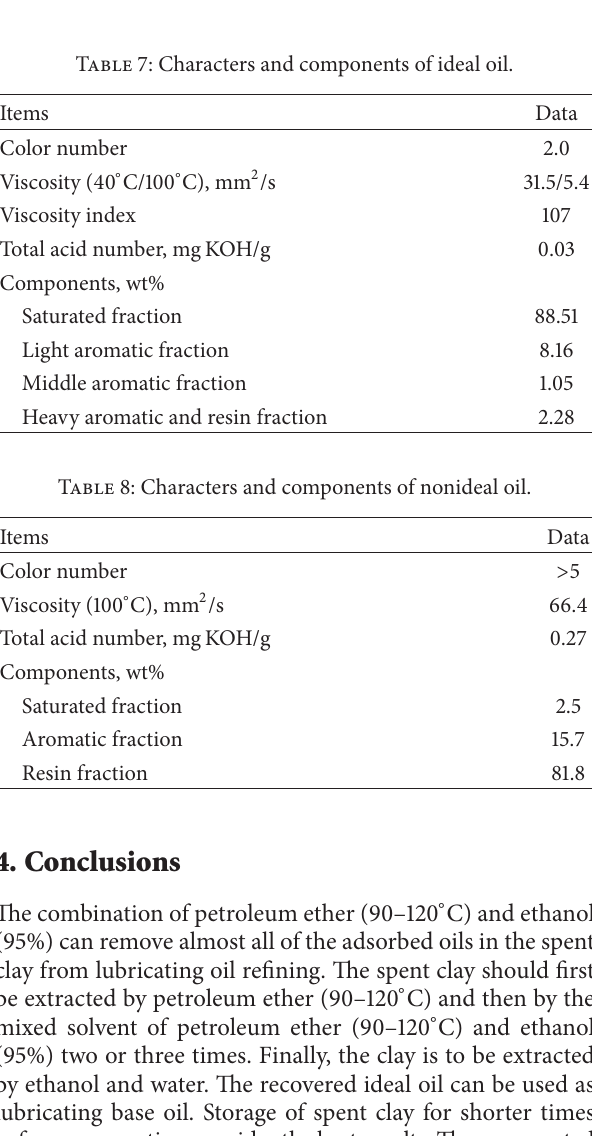
Figure 6: Effect on oil recovery of extraction number.